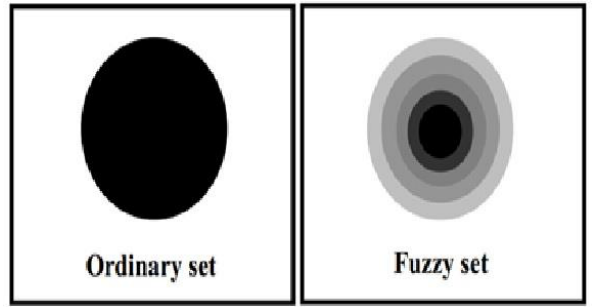
Fig. 1. Representation of fuzzy